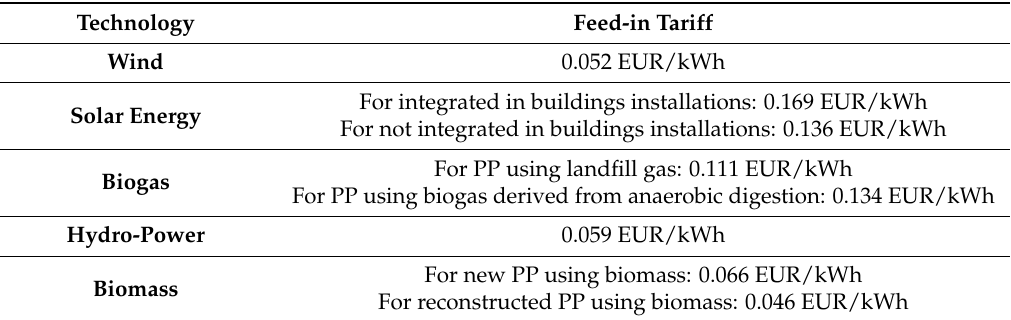
Table 5. Feed-in tariffs for renewable energy technologies with installed capacity up or equal to 10 kW. Source: created by authors based on [42]. Technology Feed-in Tariff Wind 0.052 EUR/kWh For integrated in buildings installations: 0.169 EUR/kWh Solar Energy For not integrated in buildings installations: 0.136 EUR/kWh For PP using landfill gas: 0.111 EUR/kWh Biogas For PP using biogas derived from anaerobic digestion: 0.134 EUR/kWh Hydro-Power 0.059 EUR/kWh For new PP using biomass: 0.066 EUR/kWh Biomass For reconstructed PP using biomass: 0.046